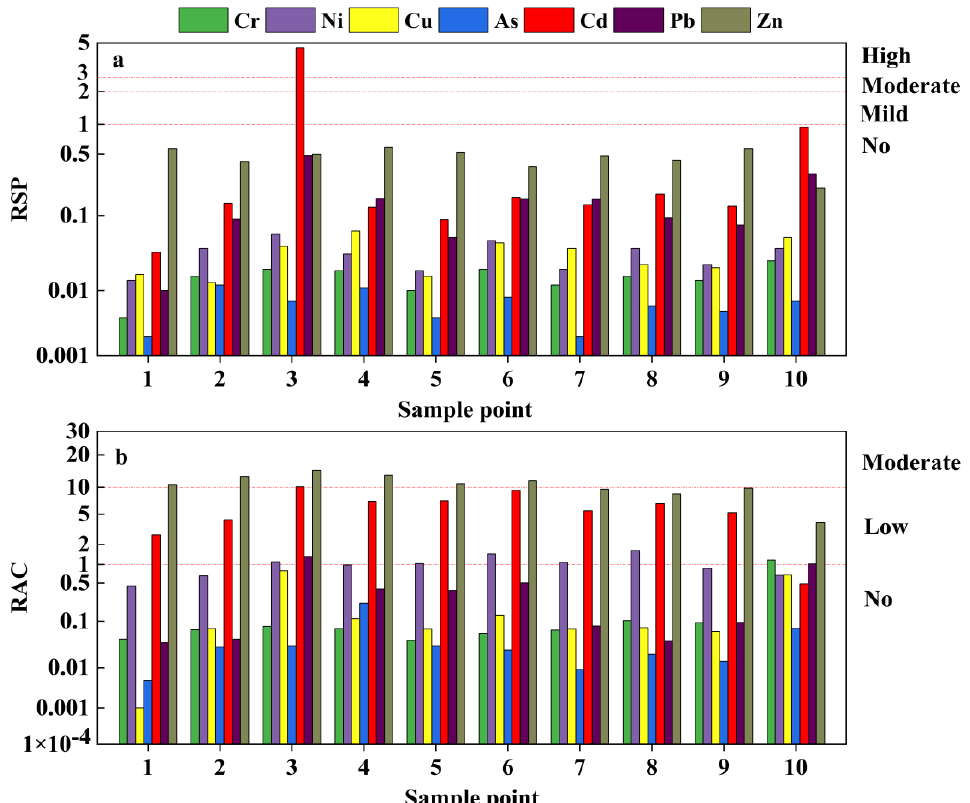
Figure 7. ( a ) Ratio of secondary phase to primary phase (RSP); and ( b ) risk assessment coding (RAC) evaluation results of soil samples.